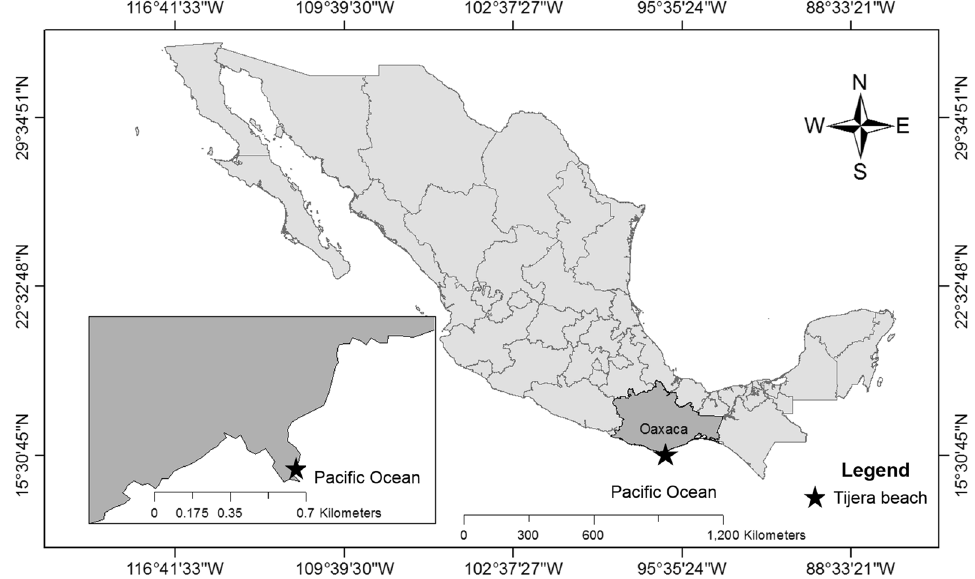
Figure 1. Location of the study area showing the position of Playa Tijera. The map in this figure was created with ArcMap Desktop (Version 10.8), https:// deskt op. arcgis. com/ es/